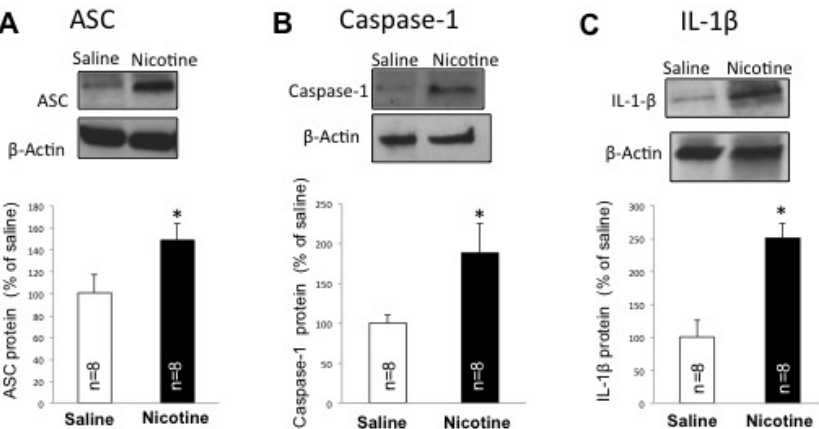
Figure 2. Nicotine increases inflammasome protein expression in the cortex of female rats. Immunoblot analyses show an increase in the inflammasome proteins ( A ) Caspase-1 ( B ) apoptosis-associated speck-like protein containing a CARD (ASC), and ( C ) IL-1 β when compared to the saline group. Data are presented mean ± SEM (* p < 0.05), n = 8.